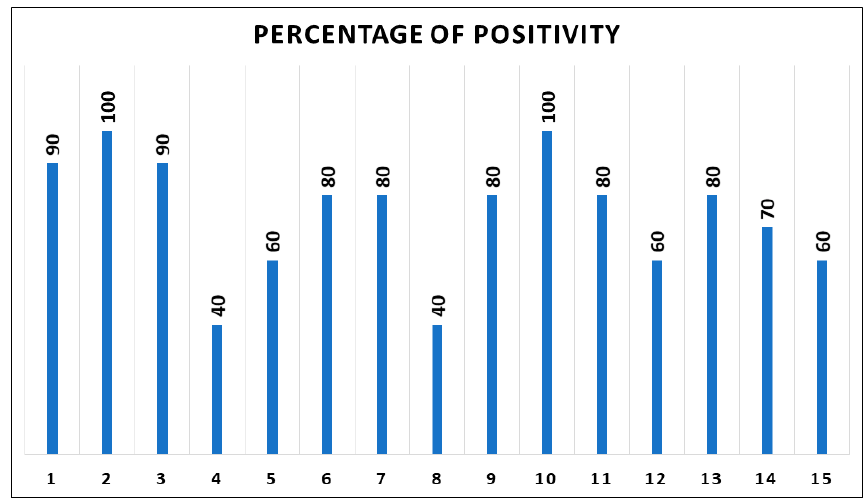
Figure 2. Percentage of BRAF immunocytochemistry-positive cells in the 15 positive cases.